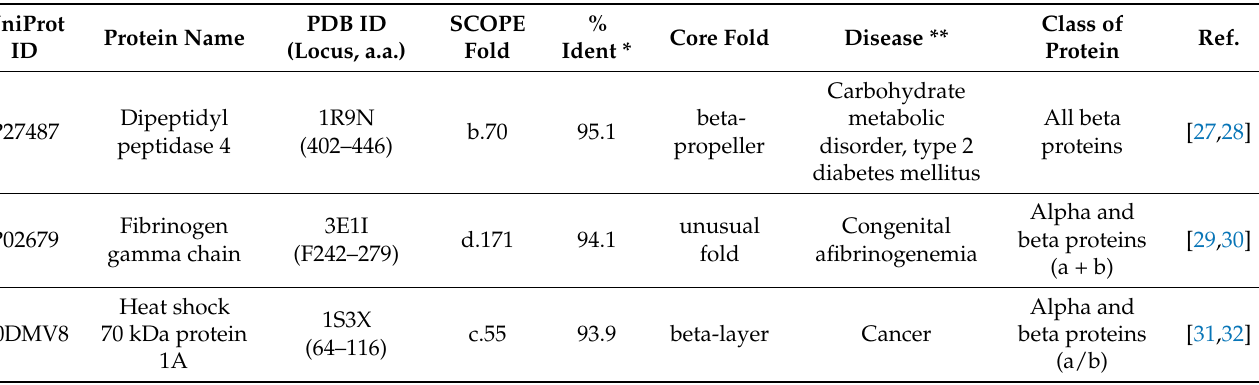
Table 1. Examples of medically significant proteins whose three-dimensional structure contains the 3 β -corner